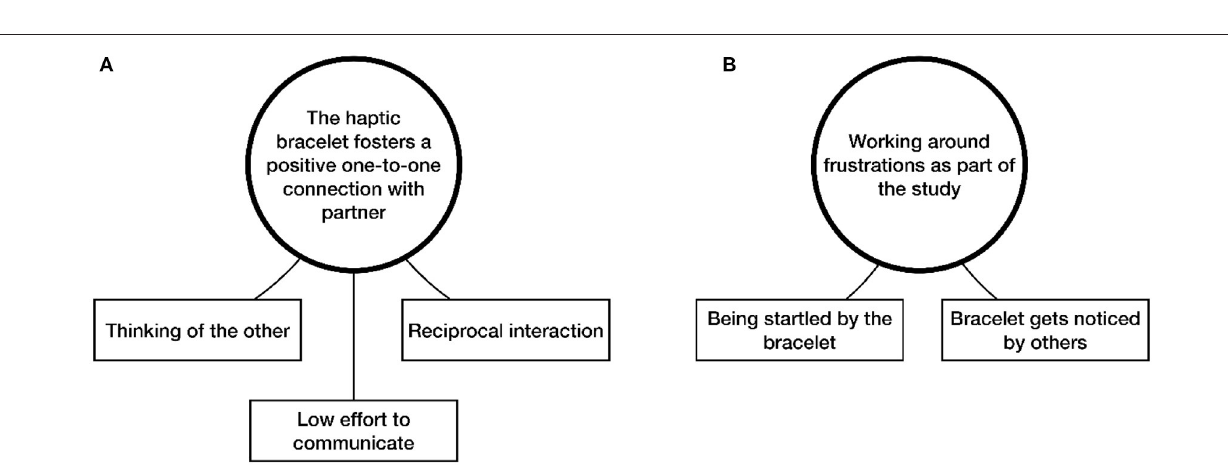
Supplementary Material R . Names, as well as place names are anonymized (“NAME” and “CITY,” respectively) in the quotes. Quotes are labeled per couple number and participant number within the couple (either 1 or